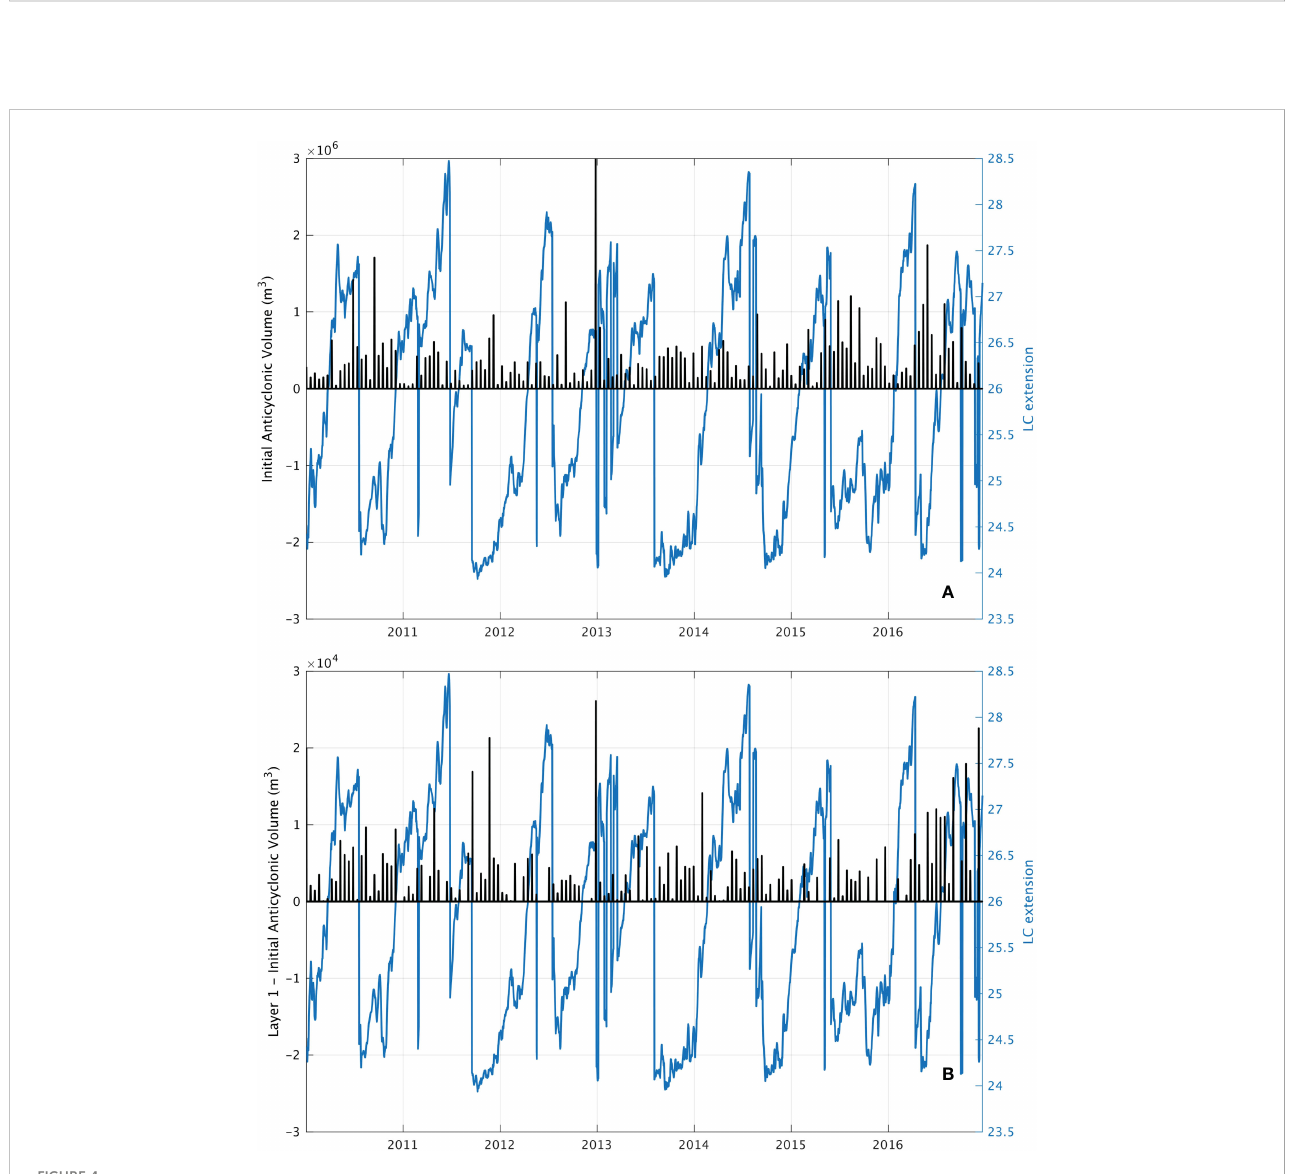
FIGURE 4 Initial volume of anticyclonic, coherent boundaries (black bars) that were detected in the northwestern Caribbean Sea and crossed the Yucatan Channel (max total volume: 300 km 3 ), along with the LC northernmost extension (blue line) (A) in the entire water column and (B) at the